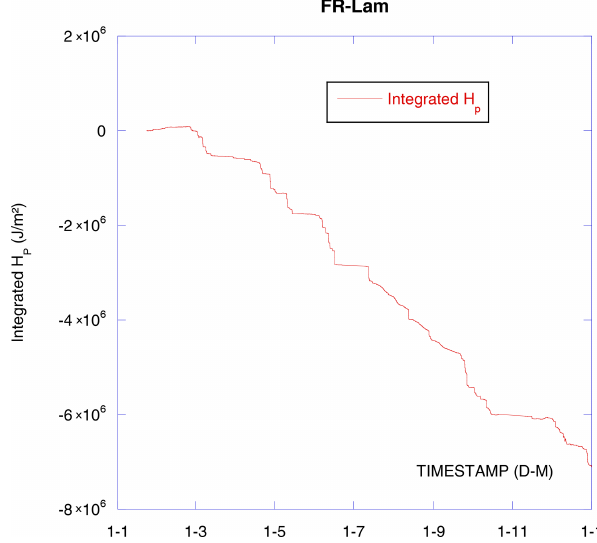
Figure 6. Rainfall soil surface temperature cooling.